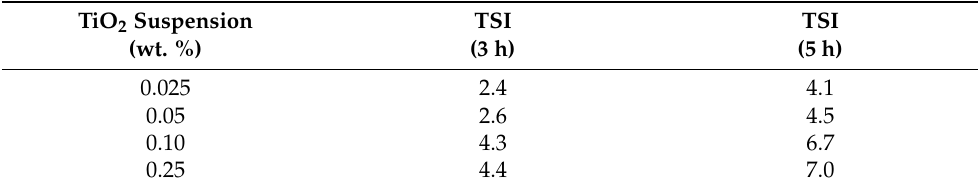
Table 2. TSI for the TiO 2 suspensions prepared without the additive.